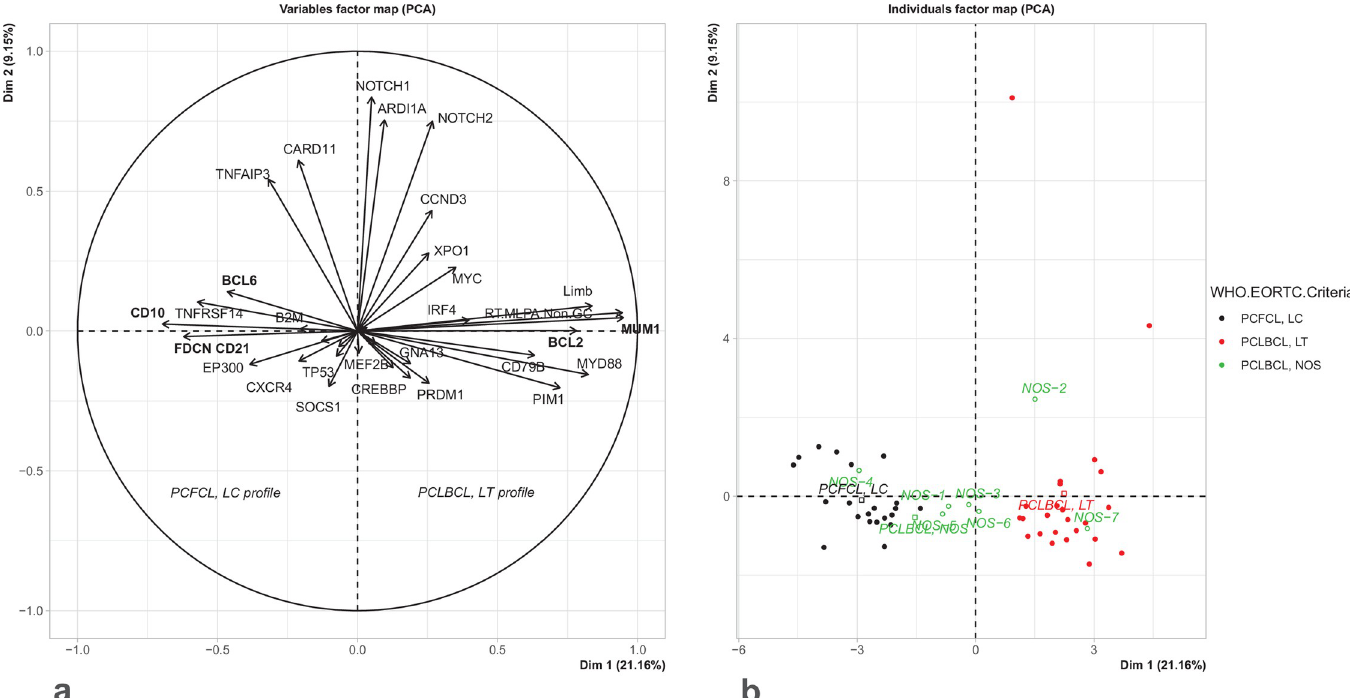
Fig 2. Principal component analysis of the expression profiling by RT-MLPA and mutational analysis. a. Variables factor map, b. Individuals factor map. PCLBCL, LT: primary cutaneous large B-cell lymphoma, leg type; PCFCL, LC: primary cutaneous follicle centre lymphoma, large cell; PCLBCL, NOS: primary cutaneous large B-cell lymphomas, not otherwise specified. Positive immunostaining are in bold by contrast to mutated genes. Principal component 1 and 2 explain 21.16% and 9.15% of the total variance, respectively.